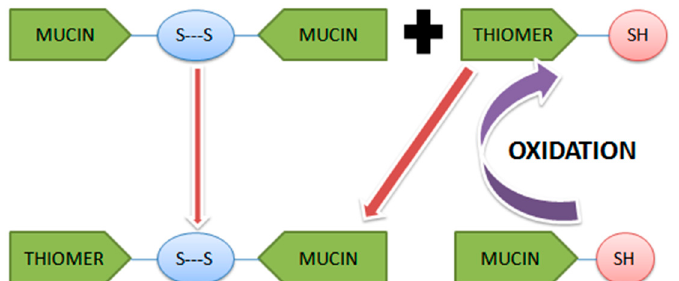
Figure 1. Mechanism of formation of disulfide bond (-SH) between thiomer and mucin.